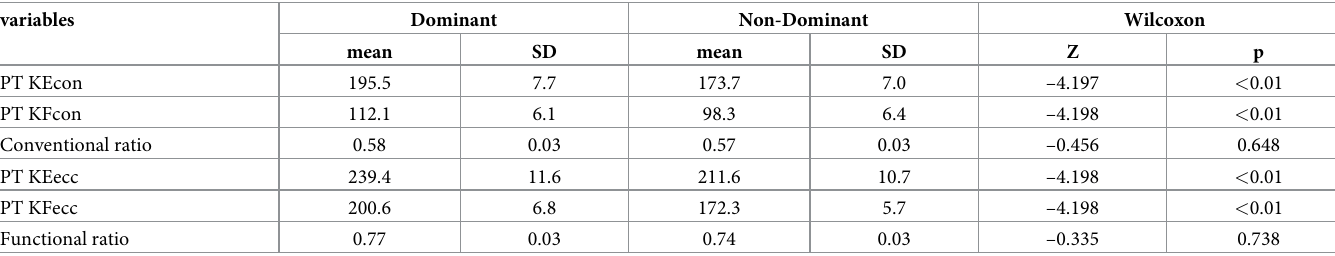
asymmetry. Bilateral differences and muscle asymmetries have been linked to several lower extremity injuries in soccer players [5, 6, 8]. Current study results have shown pronounced bilateral differences regarding knee joints between dominant and non-dominant legs. Slightly asymmetries were found in the knee agonist-antagonist muscles relationship and no imbalance effect on the hip joint. The present sample’s morphological and body composition characteris- tics are in line with the previous research samples with young soccer players [30–32]. This is of extreme importance once literature regarding strength parameters normalizes absolute values to the weight or lever length. Measurements were resulting from the isokinetic evaluation of the extension and flexion function of the knee joint in both lower limbs (i.e., 60˚/s) in different muscular actions (i.e., con and ecc). The angular velocity was selected given previous studies considering soccer players [7, 30, 33]. The 60˚/s angular velocity was previously used to evalu- ate maximum muscle resistance values [34]. Table 3. Comparative statistics for knee extensors, knee flexors and ratios considering dominant and non-dominant lower-limbs. variables